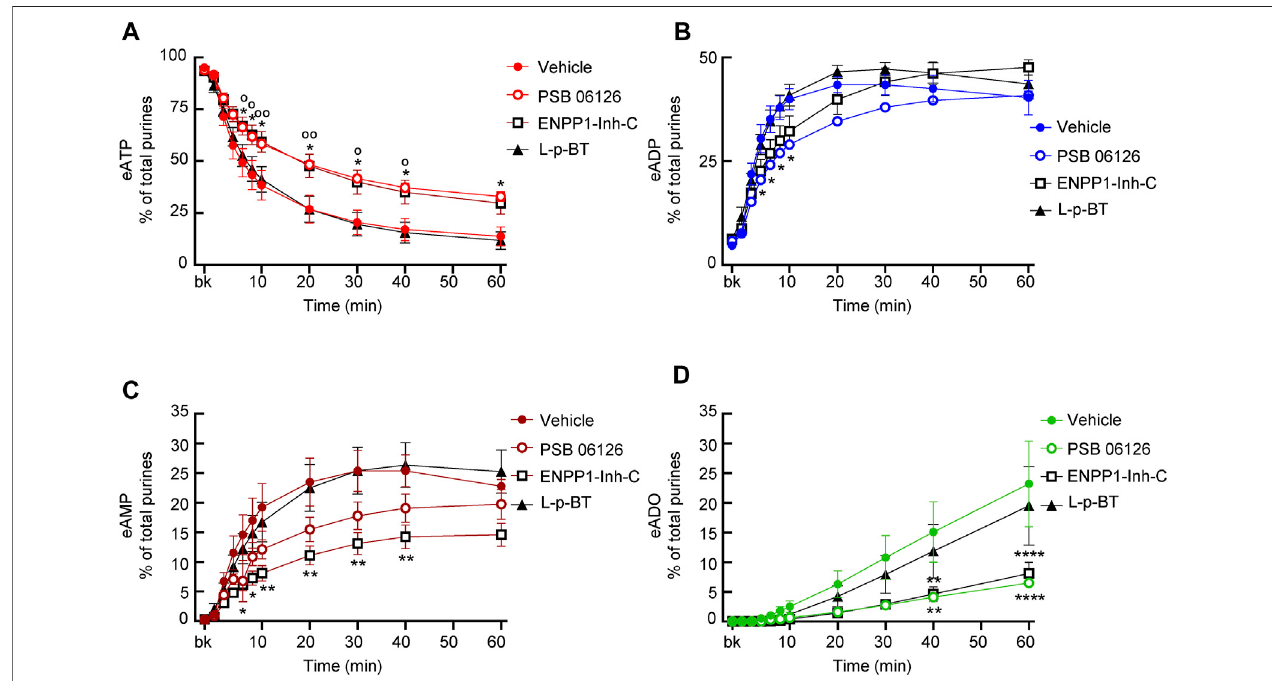
FIGURE 8 | Effects of PSB06126, ENPP1-Inh-C and L-p-bromotetramisole (L-p-BT) on hydrolysis of eATP by soluble enzymes in LP. (A – D) eATP hydrolysis by soluble enzymes in the presence of vehicle (0.1% DMSO) or PSB06126 (10 µM), ENPP1-Inh-C (50 µM) or L-p-bromotetramisole (L-p-BT) (100 µM). Asterisks denote signi fi cant difference of eATP decrease in the presence of ENPP1-Inh-C from vehicle controls. * p < 0.05, ** p < 0.01, **** p < 0.0001. Open circles denote signi fi cant difference of eATP decrease in the presence of PSB06126 and vehicle control (panel A ). o P < 0.05, oo P < 0.01.